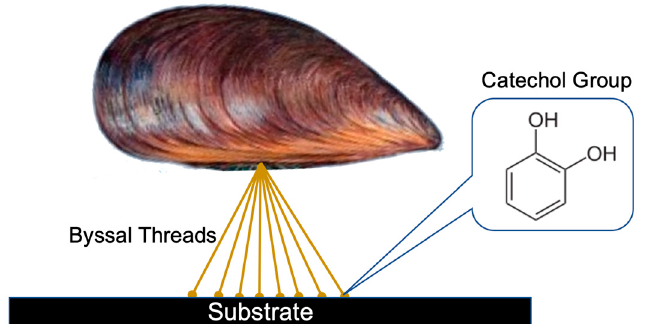
Figure 2. Schematic representation of a mussel using its byssal threads to attach to the surface of a substrate. The key chemical composition of its byssal threads is catechol groups which make up MAPs and their unique strong adhesive characteristics.